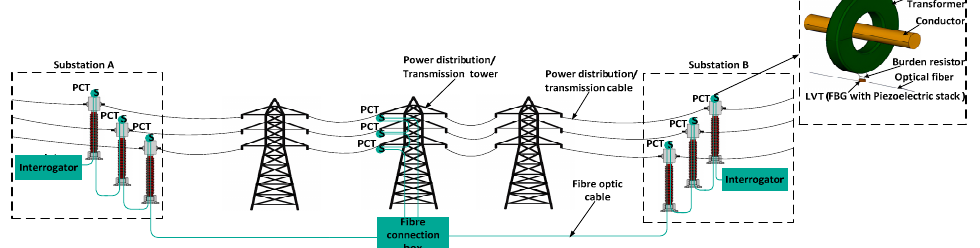
Figure 3. Example of PCT deployment at a power transmission/distribution system. An interrogator is conveniently located at a substation. Note that various other modes of deployment are possible as explained in detail in [8].